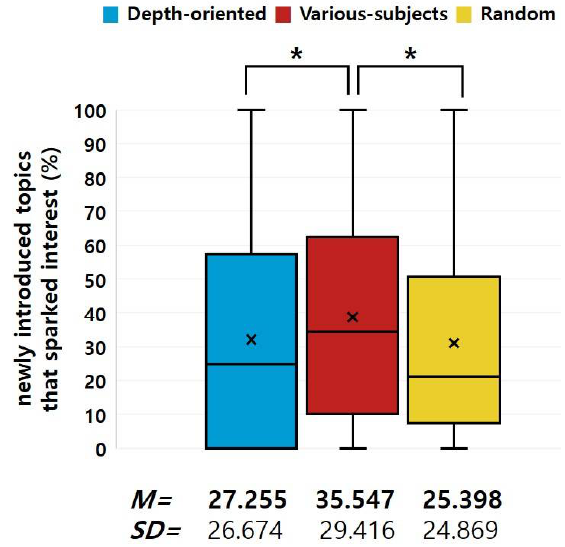
Figure 7. Proportion of newly introduced topics that QA agents sparked interest in for users.